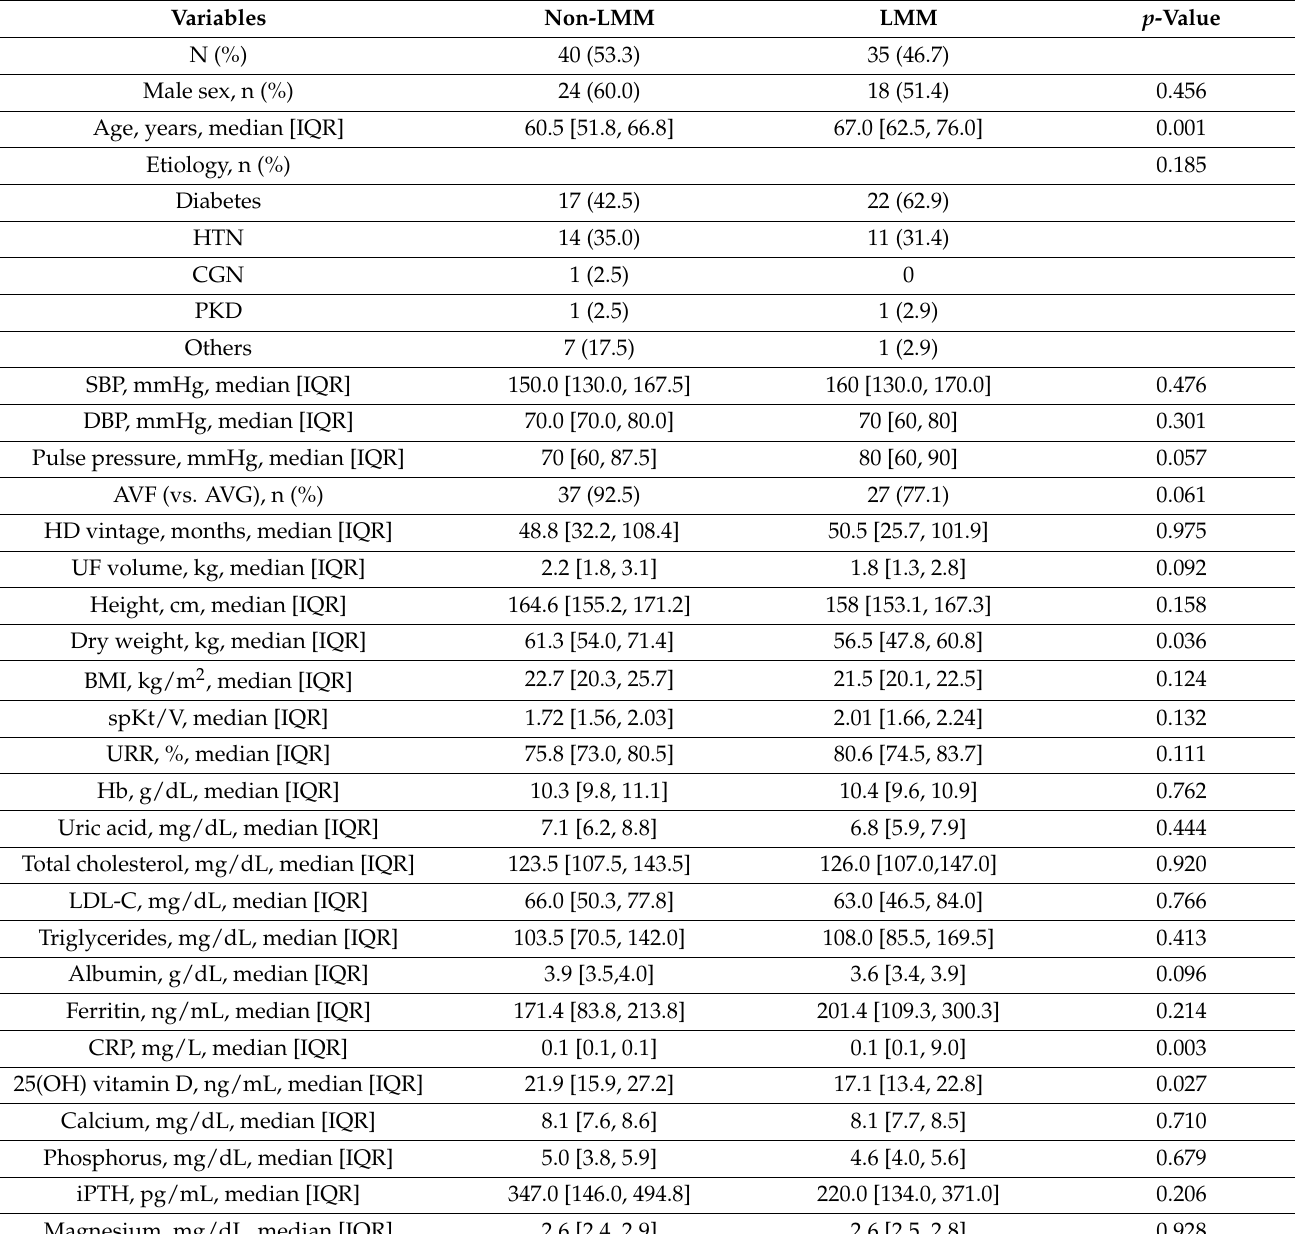
Table 1. Baseline characteristics of study patients classified by muscle